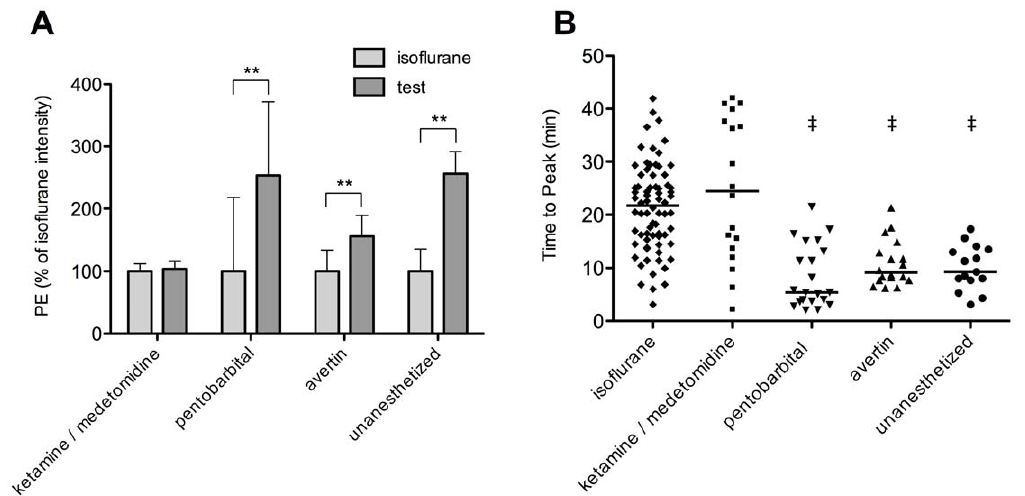
Figure 6. In vivo comparison of anesthetics. ( A ) represents the maximum BLI intensity obtained from the same mice anesthetized with isoflurane or the test anesthetic mentioned below the curve. Values were normalized to isoflurane signal intensities. ( B ) shows a scatter plot of the time to the peak signal intensity for the different anesthetics. Each data point represents a unique bioluminescent acquisition from the in vivo comparison of anesthetics study. Lines indicate the mean. There was a significantly later peak for ketamine/medetomidine and isoflurane as compared to avertin, pentobarbital and unanesthetized animals. ** p , 0.01 between indicated conditions ; { p , 0.05 compared to both isoflurane and ketamine/medetomidine .